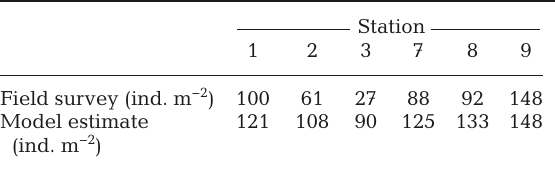
Table 5. Perinereis aibuhitensis carrying capacity assess- ments, based on field surveys and model